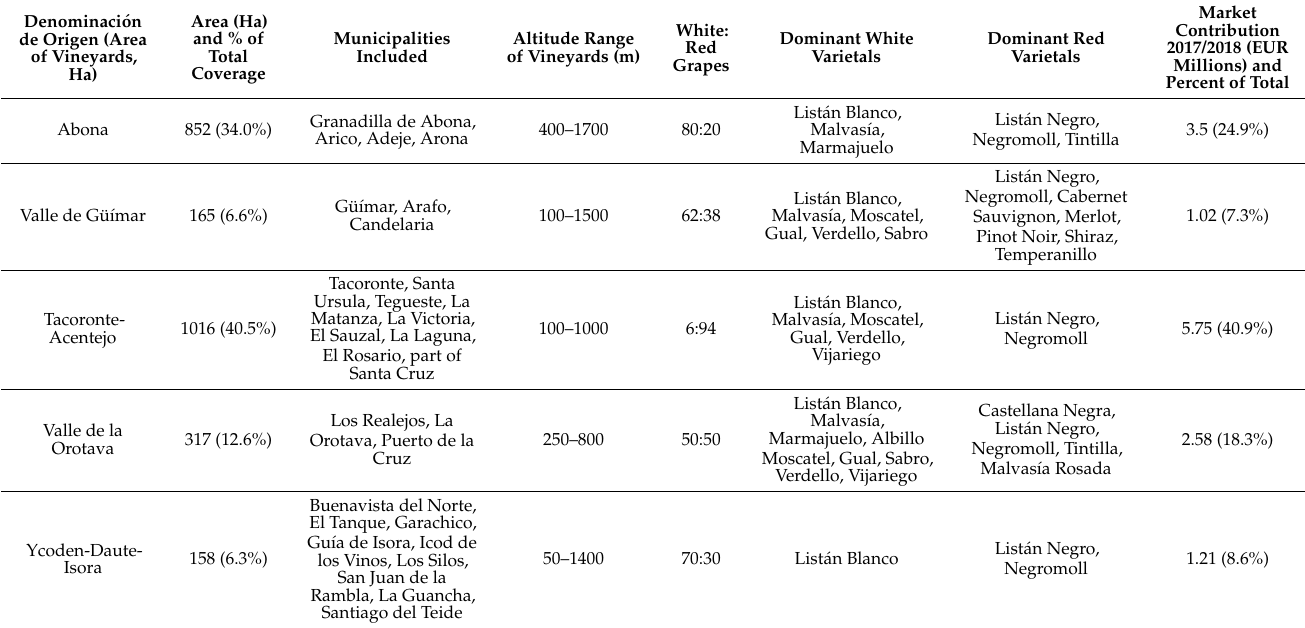
Table 1. Size, geography, varietals and economic contribution of each wine according to Denomi- naci ó n de Origen (DO) on the island of Tenerife [2,33,35,36].